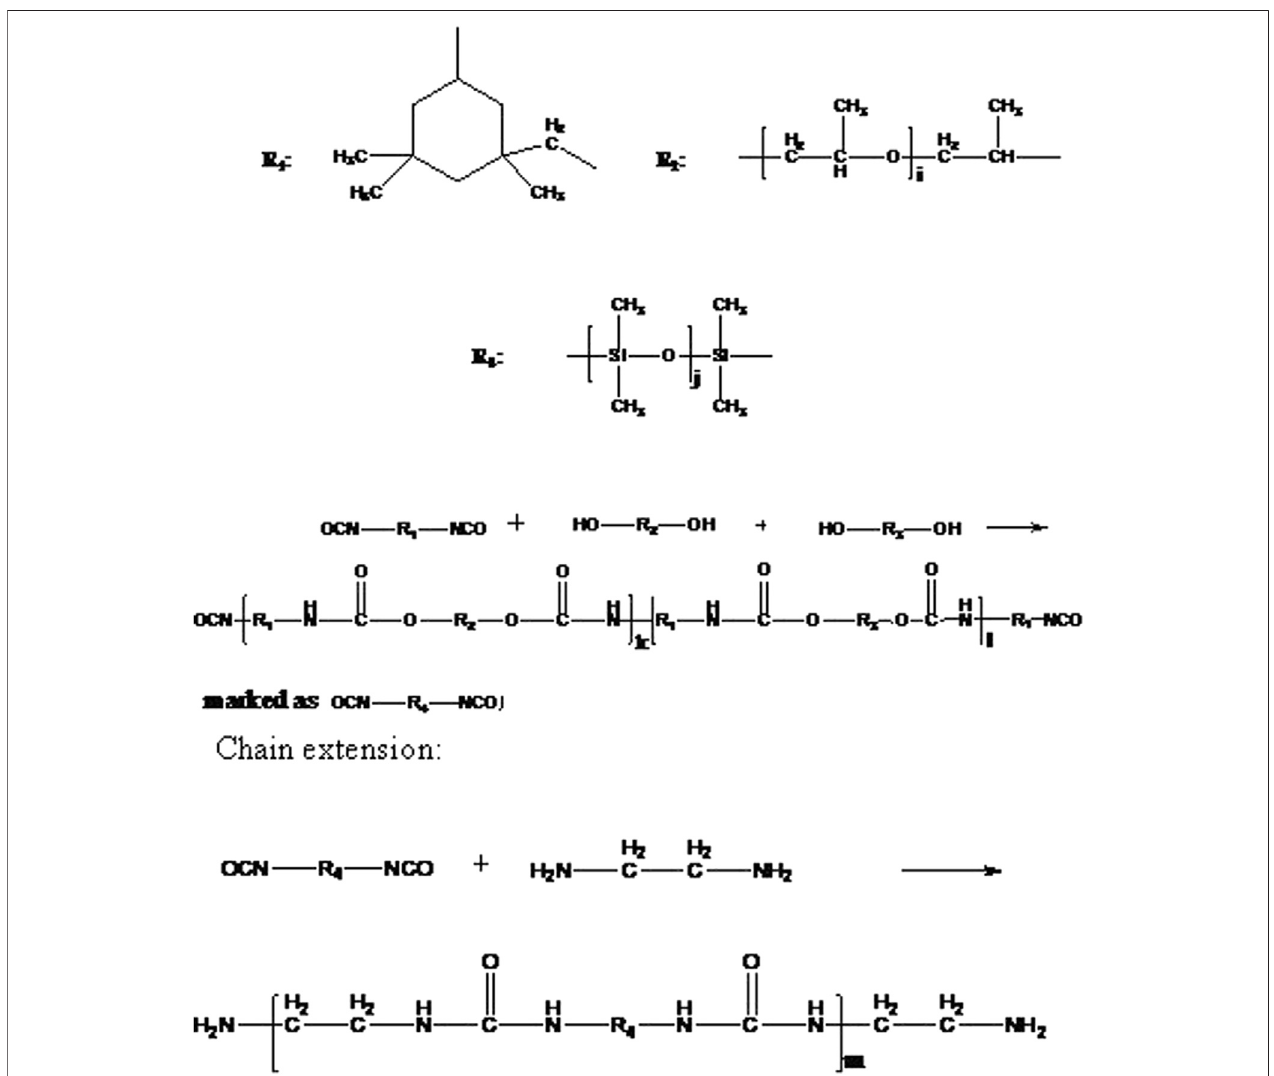
FIGURE 2 | Principle of side chain reaction and its molecular